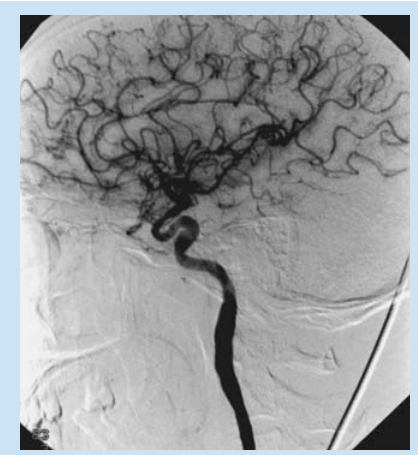
Fig. 5b. Lateral internal carotid angiogram follow- ing embolisation, showing fistula occluded and carotid artery